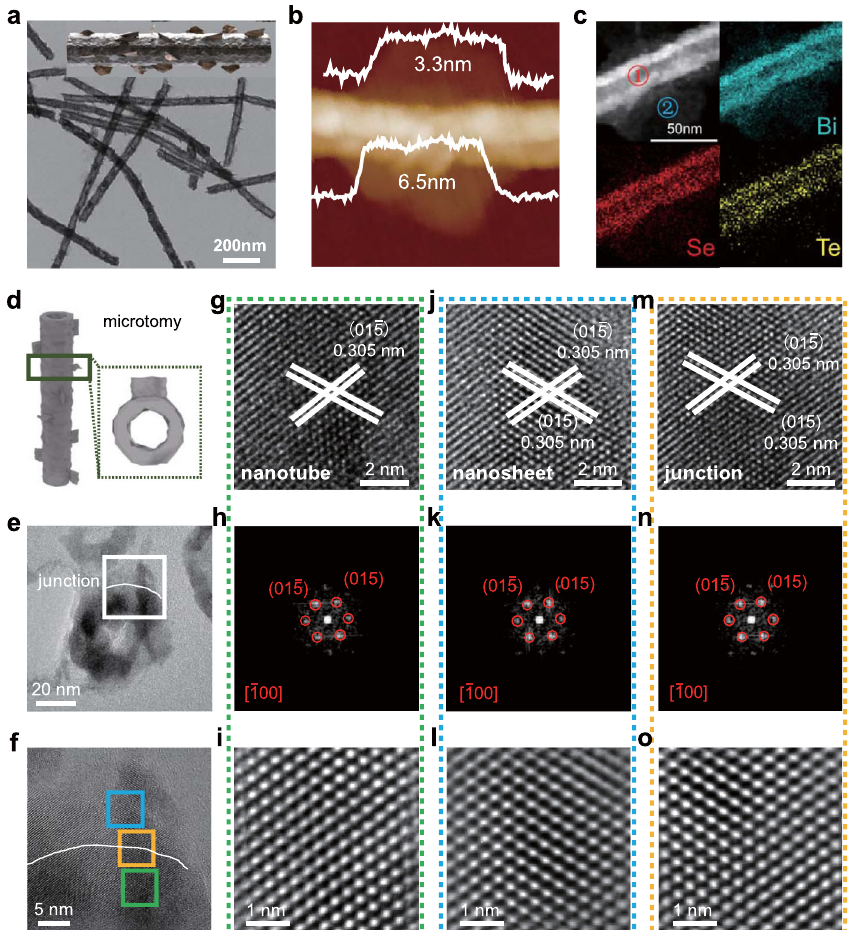
Fig. 1 Morphological and compositional characterization of BST-MHs. a TEM image of BST-MHs. Inset is a schematic geometric model. b AFM image of BST-MHs. c EDS mapping images of BST-MHs. d Schematic of the sliced BST-MHs. e , f TEM image and HRTEM image of the junction. g – i HRTEM image, FFT, and the inverse FFT of the nanotube in the green domain of ( f ). j – l HRTEM image, FFT, and the inverse FFT of the nanosheet in the blue domain of ( f ). m – o HRTEM image, FFT, and the inverse FFT of junction in the yellow domain of ( f